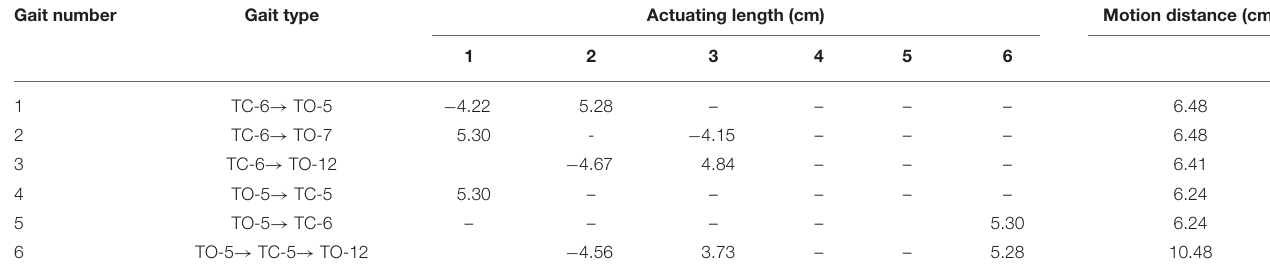
TABLE 5 | Locomotive gait for the six-strut tensegrity structure. Gait